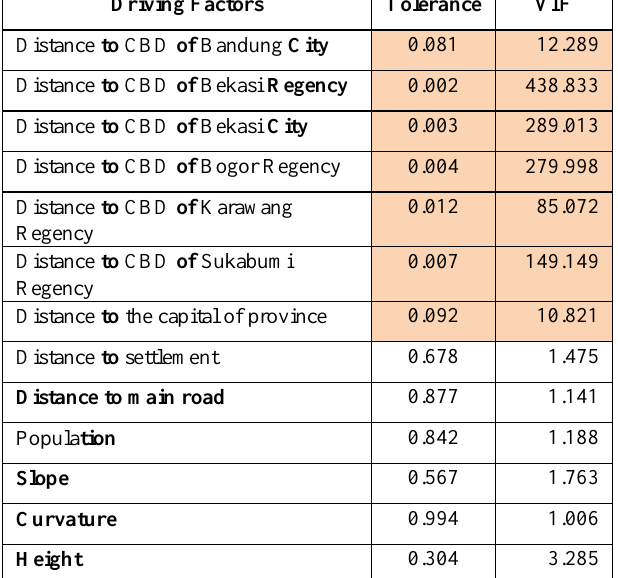
Table 1. Result of multicollinearity test using VIF and Tolerance value